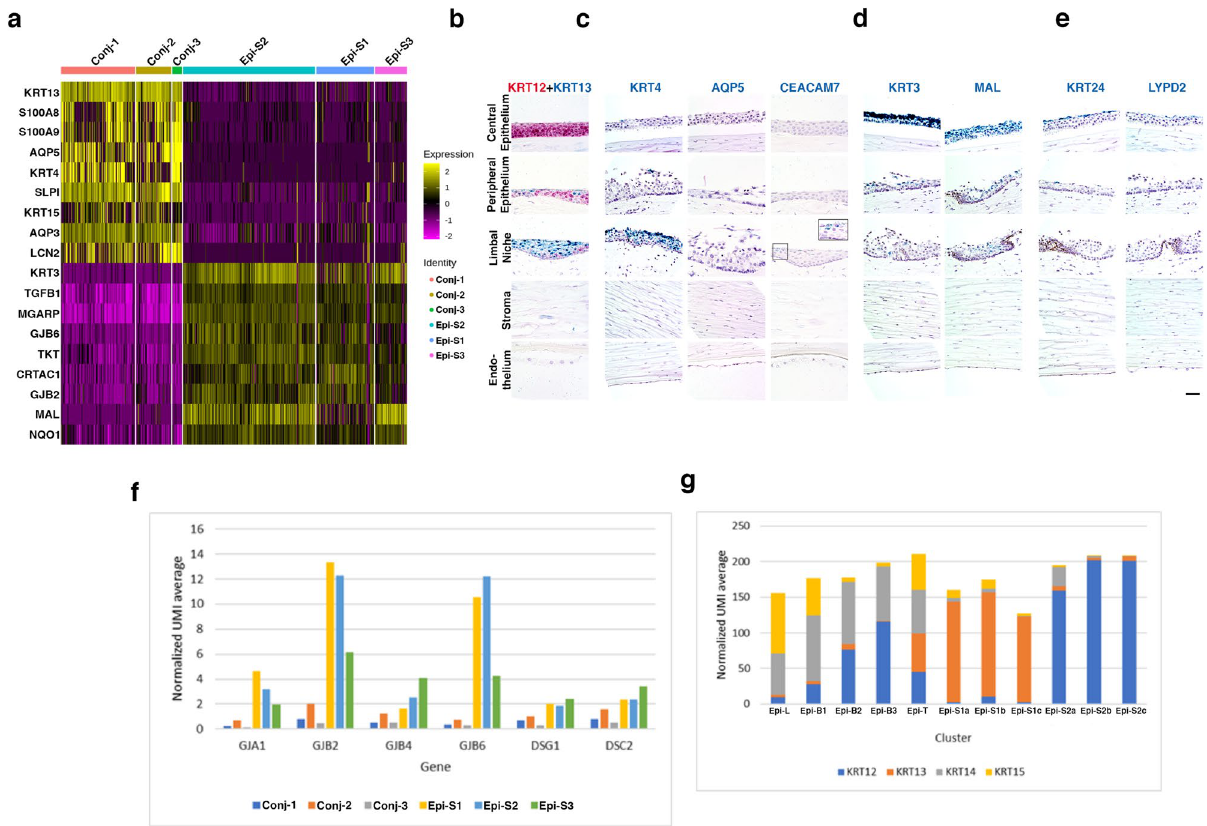
Figure 6. Molecular characteristics of conjunctival and corneal epithelial cells. (a) Heatmap of the top-most significantly differentially expressed genes between conjunctiva (Conj-1-3) and cornea (Epi-S1-3) that also overlap with cornea and conjunctiva comparison (from Fig. S6). RNAscope of selected markers from Fig. 4a. on human cornea of (b) KRT12 (red) as mature cornea epithelium marker and KRT13 (green) as conjunctiva marker, (c) conjunctival epithelial cell group Conj-1-3 genes KRT4, AQP5 , and CEACAM7 (d) superficial mature corneal epithelial cell group Epi-S1-3 genes KRT3 and MAL , (e) cluster Conj-3 and Epi-S3 epithelial cell genes KRT24 and LYPD2 (scale bar: 50 uM) . (f) Significant differentially expressed genes encoding cell junction proteins between groups conjunctival (Conj-1-3) and corneal (Epi-S1-3) epithelium. (g) Expression patterns of keratins KRT12 , KRT13 , KRT14 , and KRT15 in the conjunctival and corneal epithelial cell